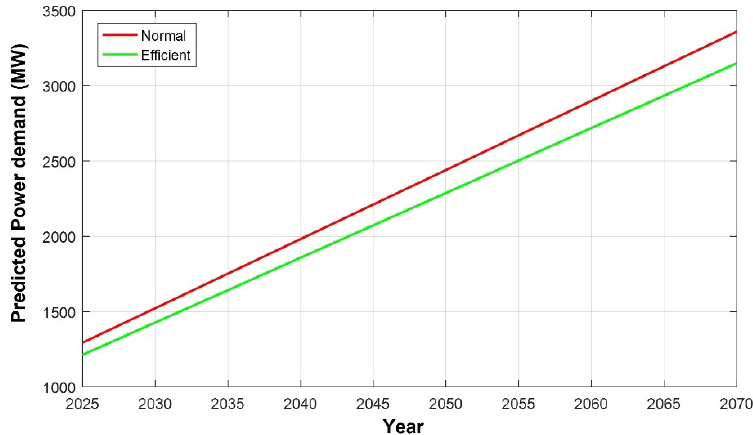
Figure 12. Predicted power demand of Dhaka with and without system loss.